Question: Condense the content of this figure into a single sentence.
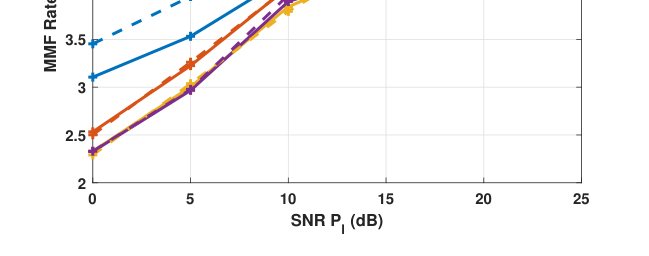
Answer: MMF rate versus LEO SNR Pl for different GEO SNR Pg and network loads. Ntg = 4, Ntl = 3, M = 2, N = 6, K = 4.